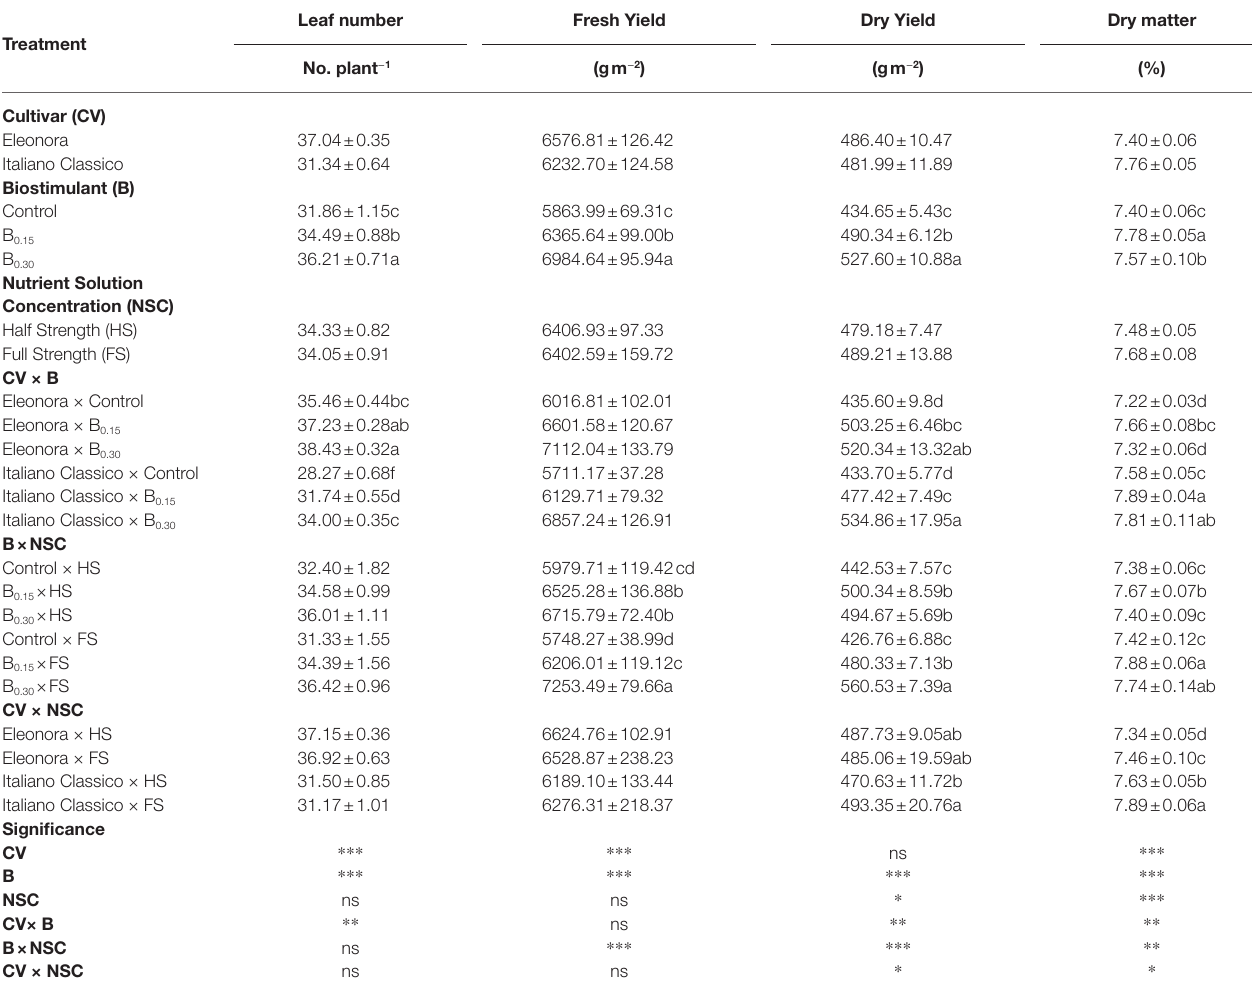
TABLE 1 | Analysis of variance and mean comparisons for leaf number, fresh yield, dry yield, and dry matter of Eleonora and Italiano Classico genotypes grown hydroponically under two nutrient solution and dose of biostimulant.